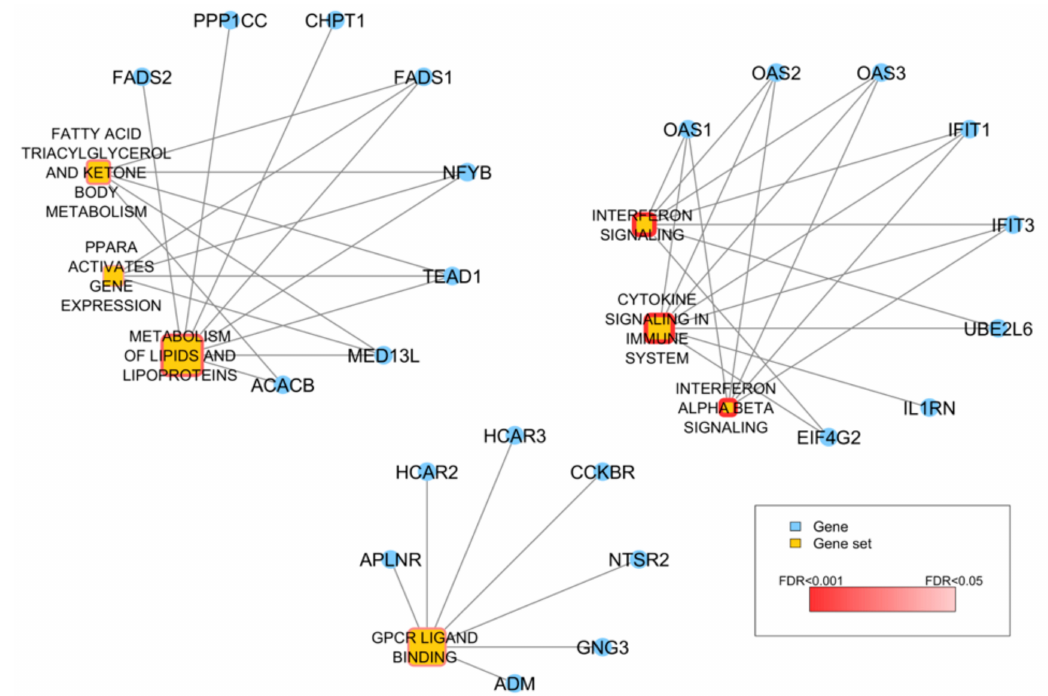
Figure 6. Over-representation analysis of the 128 genes with concordant sCNA and expression. Network showing the 7 Reactome gene sets significantly over-represented in the list of 128 genes. Yellow nodes represent gene sets and the size of the node is proportional to the number of genes catalogued in the gene set. The significance of the over-representation is represented by a dark-to-light red color scale. Blue nodes represent genes and are connected to a gene set if they are among its gene members.